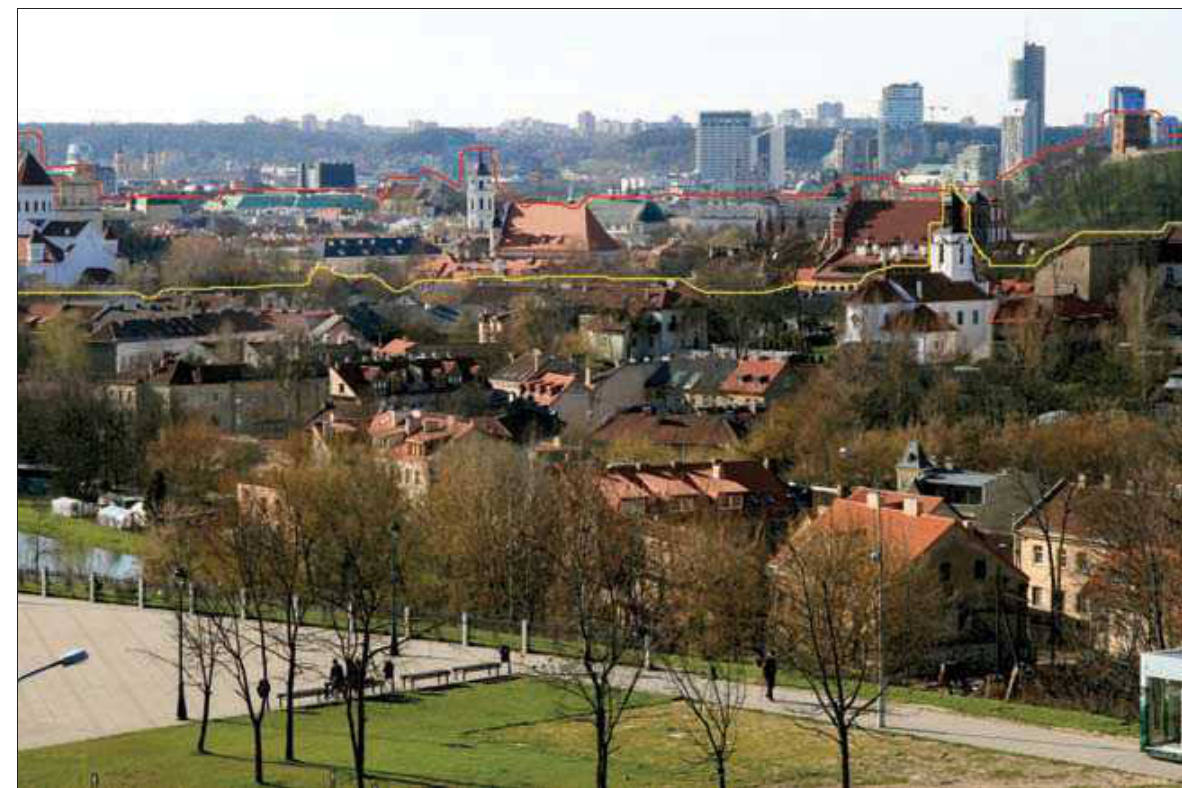
Fig. 5. Vilnius old town panorama, shaped by the historic town kernel and historic